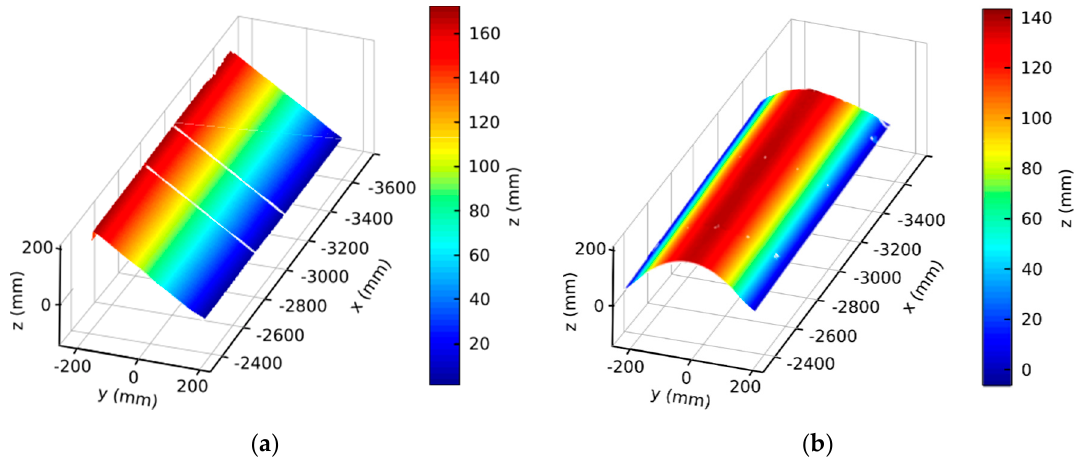
Figure 11. Reconstruction of the reference plane ( a ) and of the m-PTC ( b ).